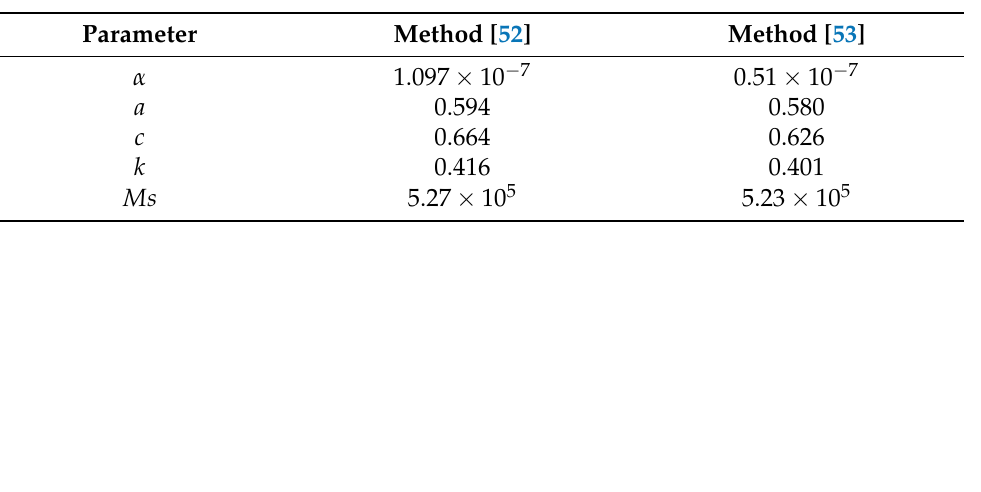
Table 1. Jiles–Atherton parameters of a ring core of VITROVAC 6025F at 10 Hz identified by the methods described in [52] Copyright 2022 Elsevier and [53] Copyright 2022 AIP